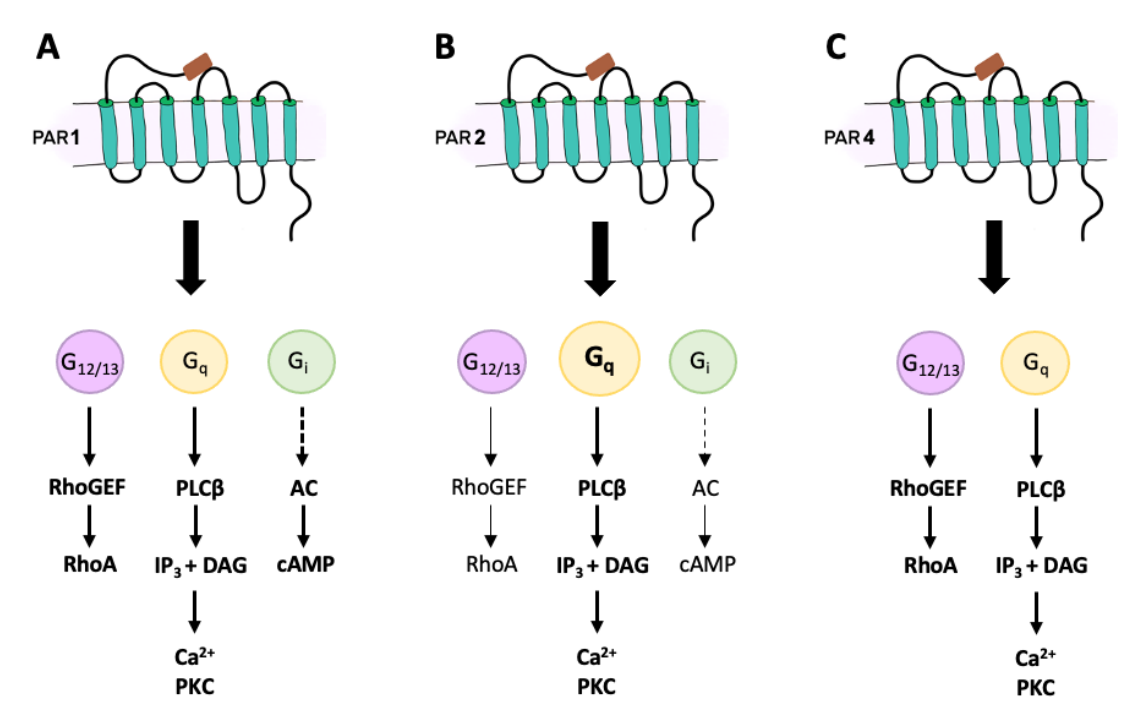
Figure 1. Downstream signalling pathways for PAR-1 ( A ), PAR-2 ( B ), and PAR-4 ( C ). Rho guanine nucleotide exchange factor (RhoGEF); GTPase RhoA (RhoA); phospholipase- Cβ (CPLCβ); phosphatidylinositol 4,5 -bisphosphate (PIP2); inosi- tol triphosphate (IP 3 ); diacylglycerol (DAG); protein kinase C (PKC); cyclic adenosine monophosphate (cAMP).